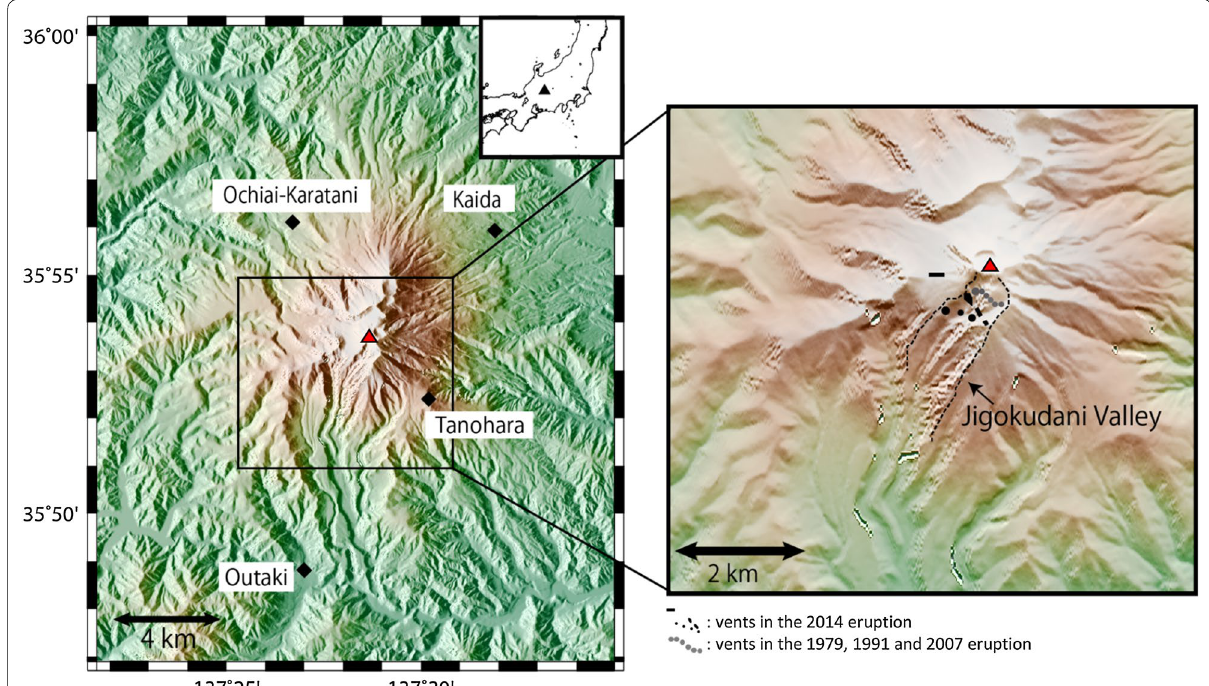
Fig. 1 Map of the study area. The inset is a close view of the summit area and corresponds to the area of interferograms (Figs. 3, 4) and modeling (Fig. 5). Most of the hydrothermal activity at the Ontake Volcano occurs around the Jigokudani Valley (indicated with the dashed line). The black diamonds indicate GNSS stations deployed around the edifice of the Ontake Volcano. Eruptive vents are also